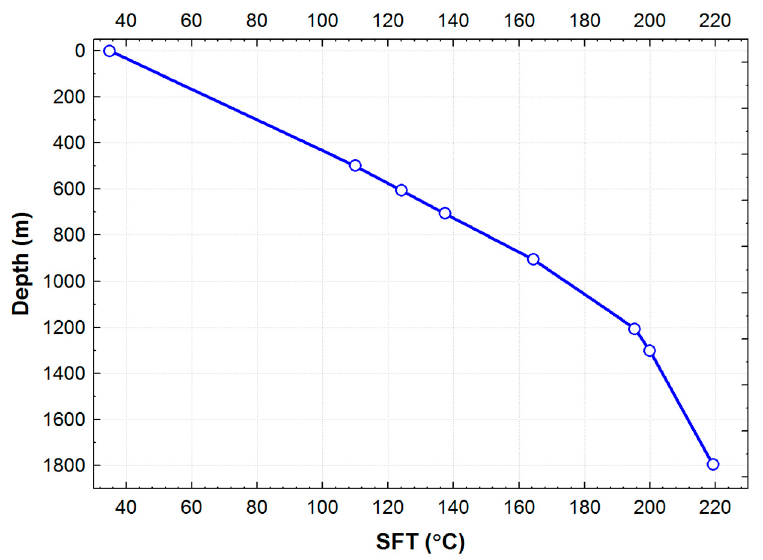
Figure 8. Temperature profile from static formation temperatures of well W-LV5 from Las Tres Vírgenes geothermal field (reported by Verma et al. [30]).